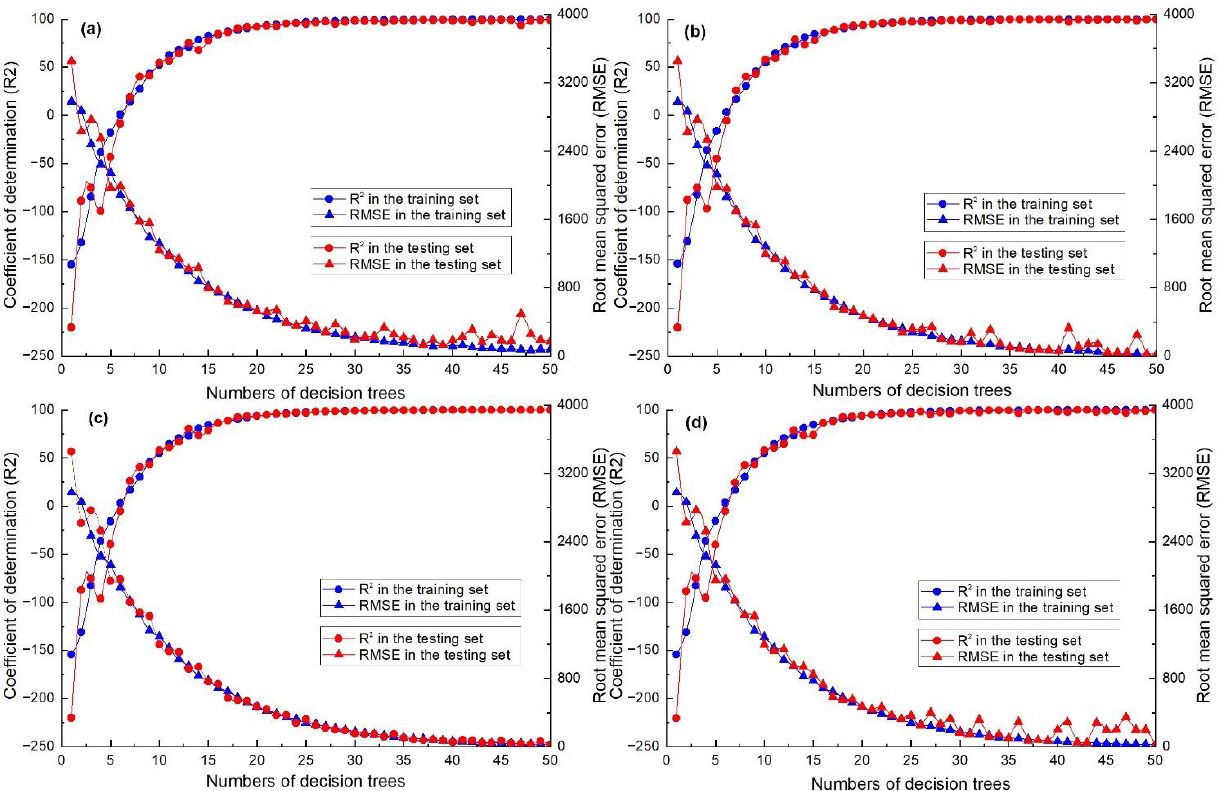
Figure 10. The performance of XGBT according to the numbers of decision trees: ( a ) based on the original data set, ( b ) based on the PCA data set, ( c ) based on the ISOMAP data set, ( d ) based on the UMAP data set. Table 6 summarizes the prediction results based on different data reductions for five chemical parameters. All in all, prediction results based on XGBT have achieved better results compared to lightGBM models. Different from PCA-lightGBM models, PCA- XGBT models have a slight edge over the (original data)-XGBT models in the testing set. The prediction of five chemical parameters based on the UMAP-XGBT model showed the best performance with an R 2 higher than 0.99 in the training set and testing set. Table 6. Comparison of the XGBT prediction models based on different manifold learning methods. Data Set